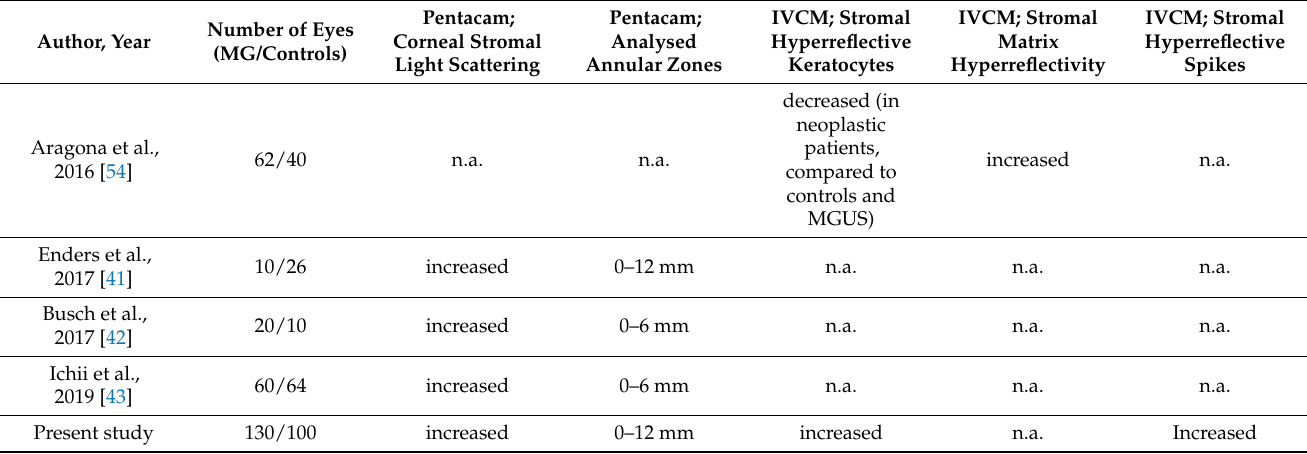
Table 4. Results of Pentacam and in vivo confocal microscopy (IVCM) analysis in subjects with monoclonal gammopathy (MG) and controls in previous studies [41–43,54] and in our present